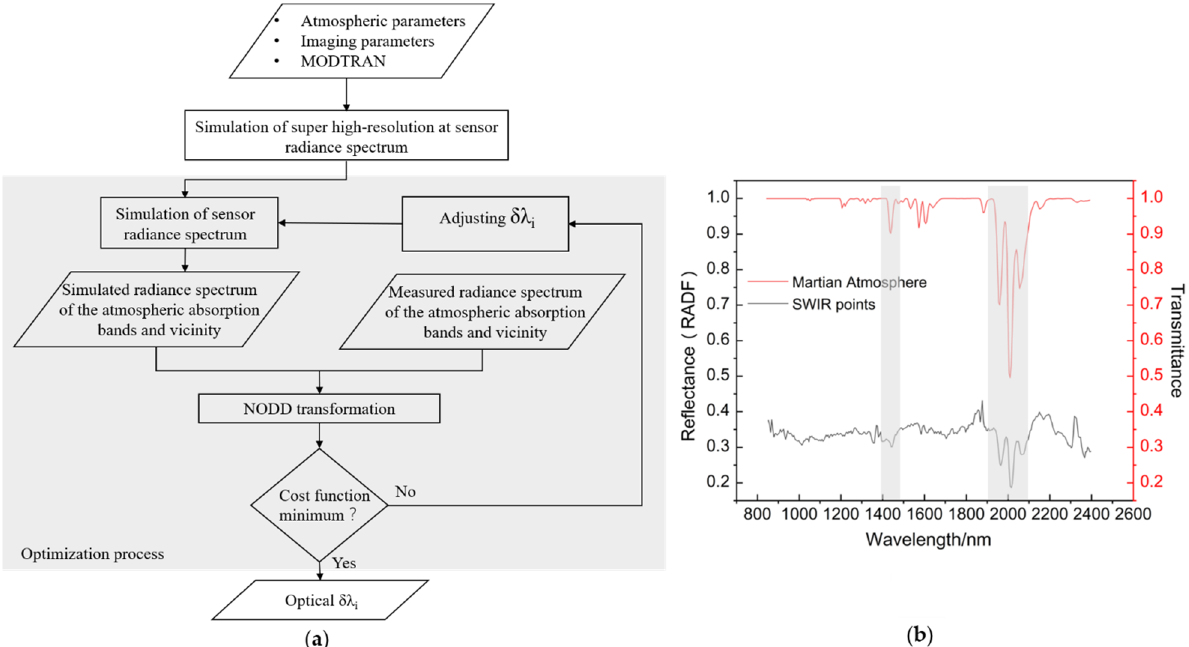
Figure 3. ( a ) Flow chart of central wavelength correction technique based on characteristic spectral absorption and schematic of characteristic spectrum. ( b ) Comparison of atmospheric transmittance and reflectance (black axis indicates the radiance factor (RADF) calculated from the detection target acquired by the sensor; red axis indicates the Mars atmospheric transmittance at the corresponding moment obtained by MODTRAN simulation).